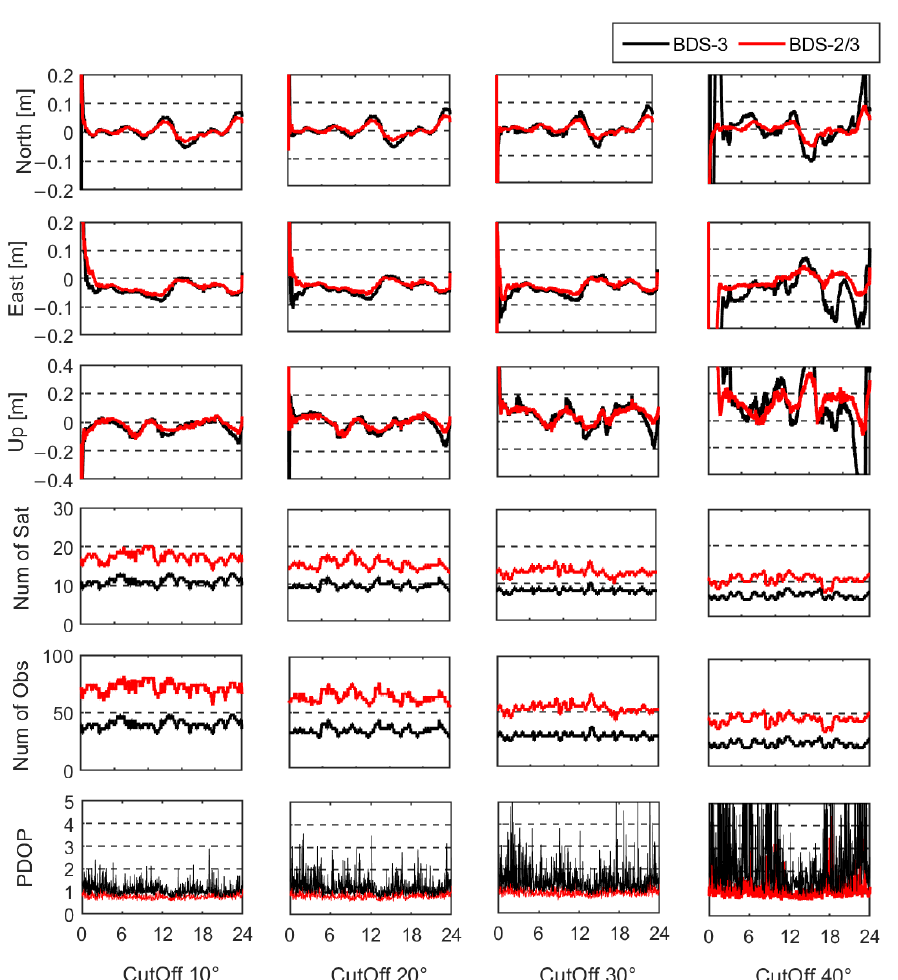
Figure 2. The location of selected stations for static experiments.